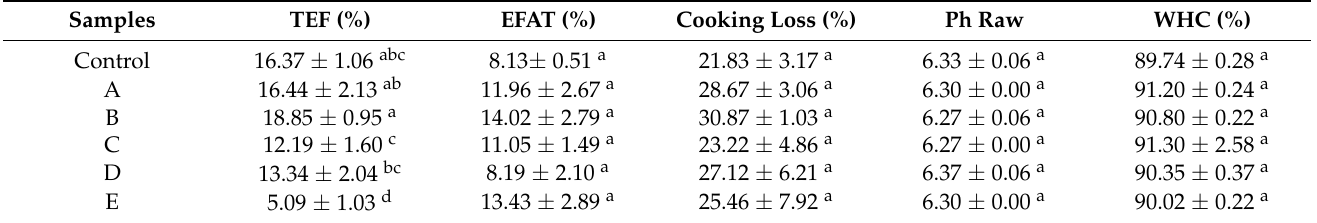
Table 2. The cooking loss, pH values, and water-holding capacity of the fat-replaced samples with palm shortenings (PS) of various melting ranges (MR) as compared to the control sample with chicken